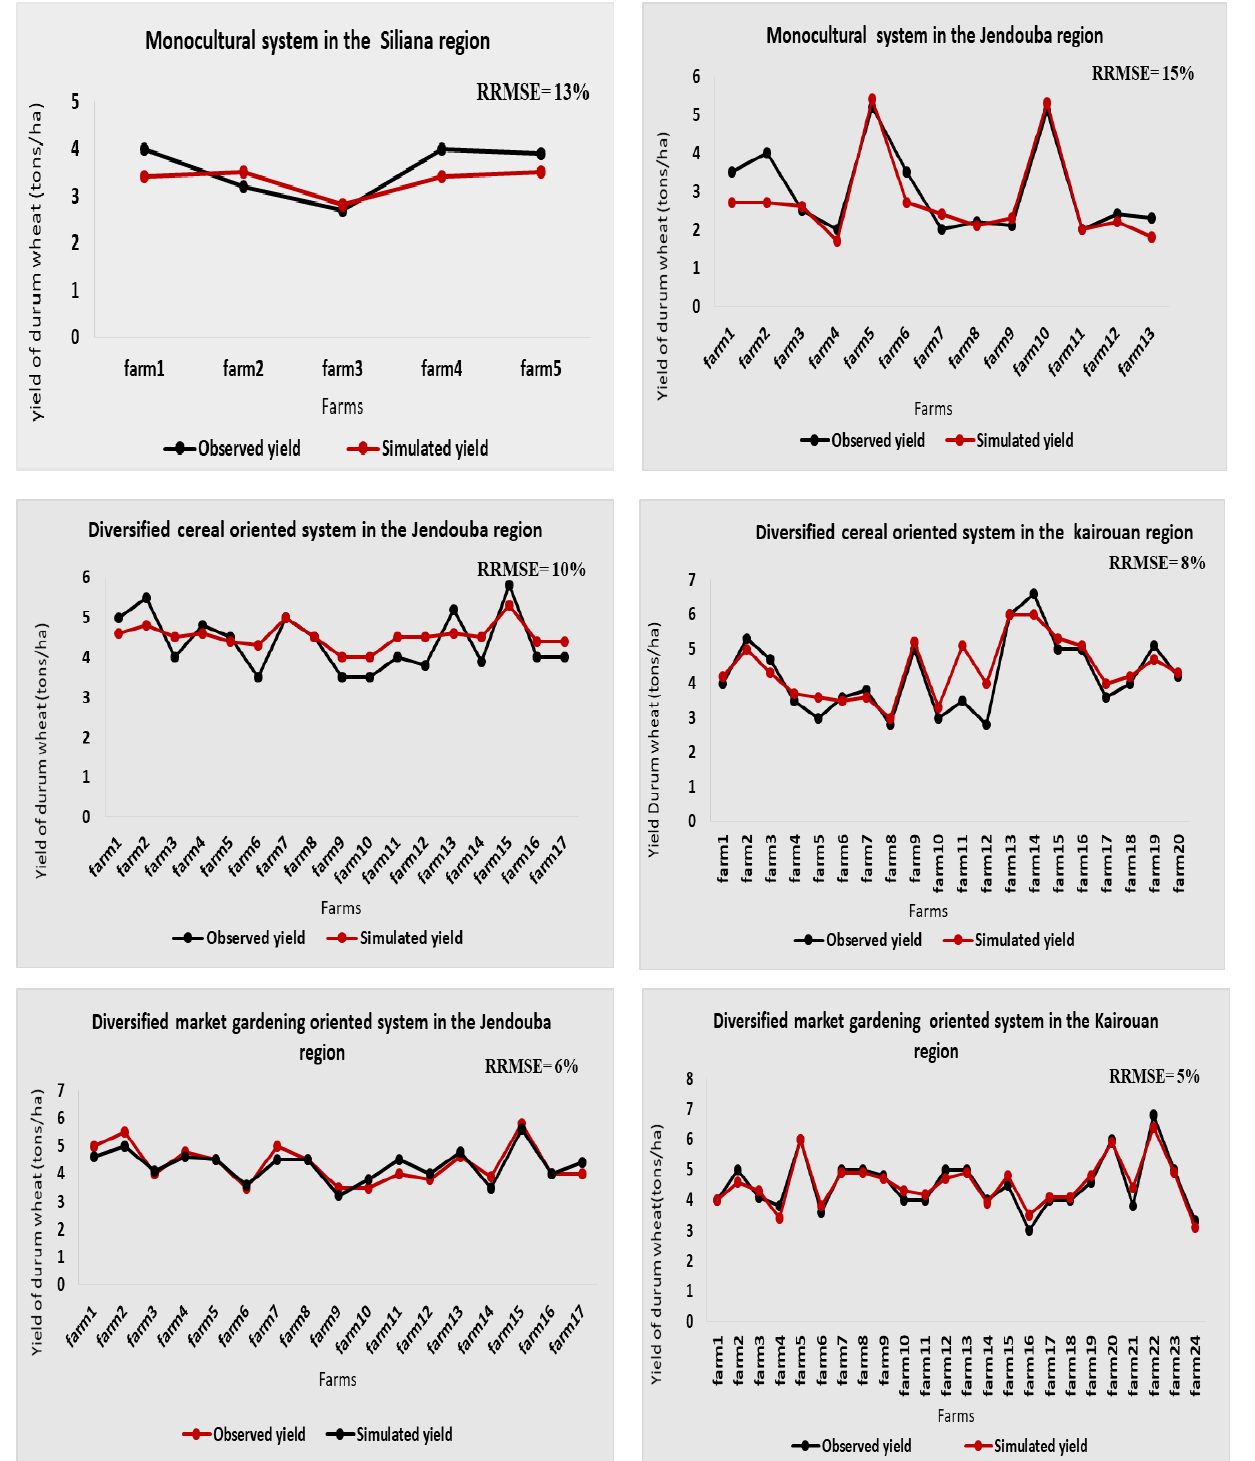
Figure 4. Validation of CROPSYST for each farming system.